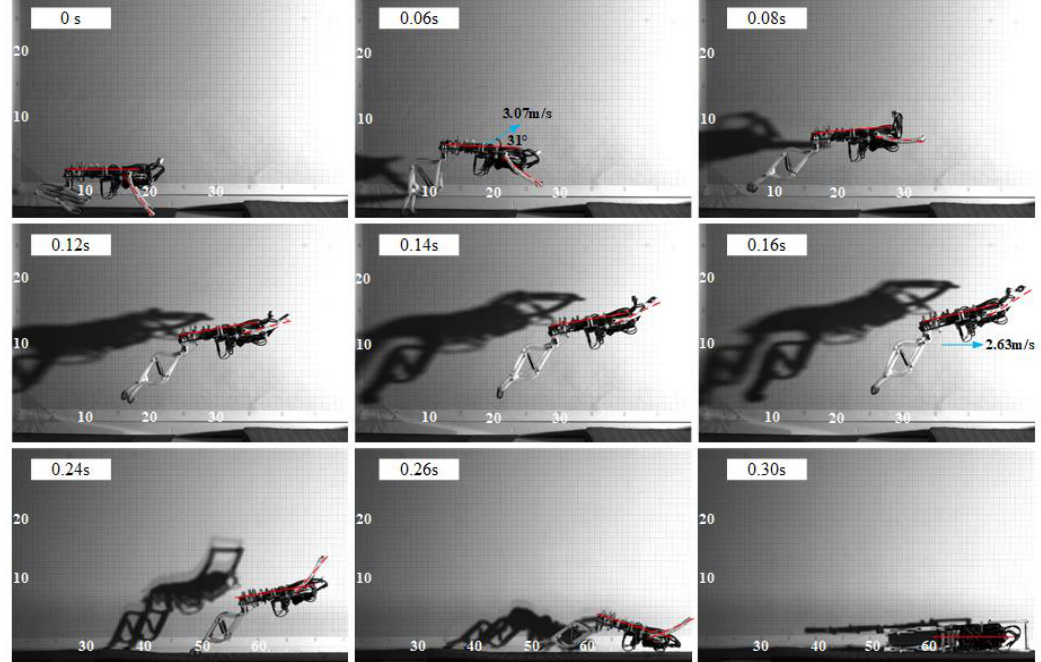
Figure 24. Motion sequence of jumping for gliding when the forelimbs are actuated. The solid red lines denote the body, the dotted red lines denote the forelimbs, and the blue arrows denote the direction of velocity.